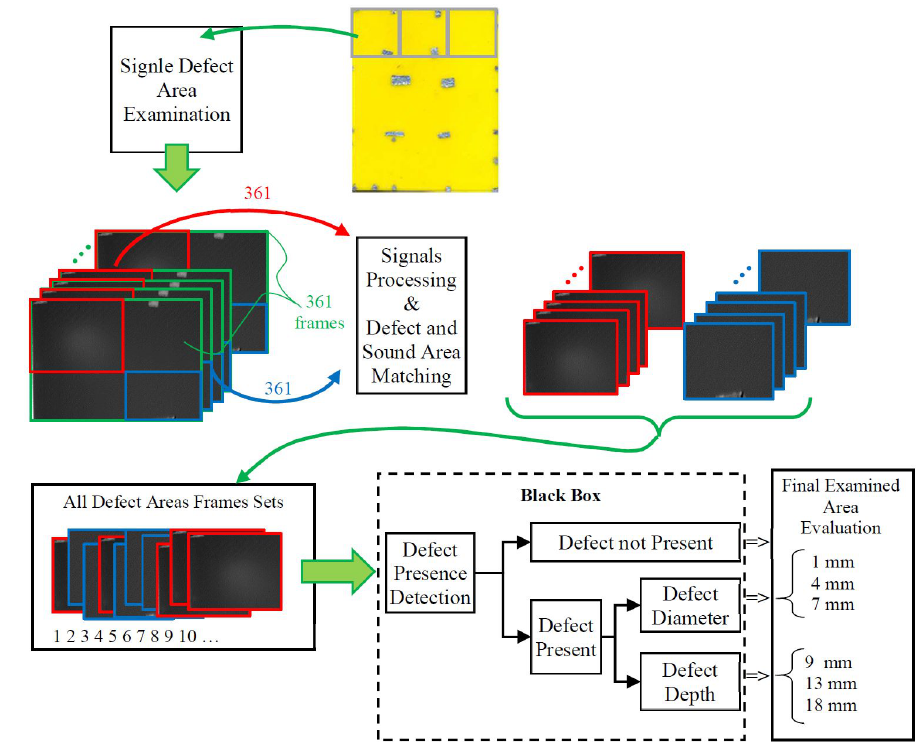
Figure 12. The architecture of the designed